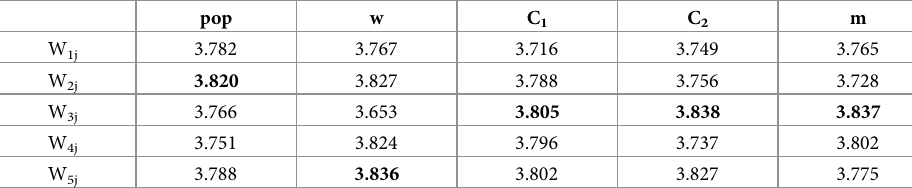
Table 3. Analysis of the PSO-ELM orthogonal array test